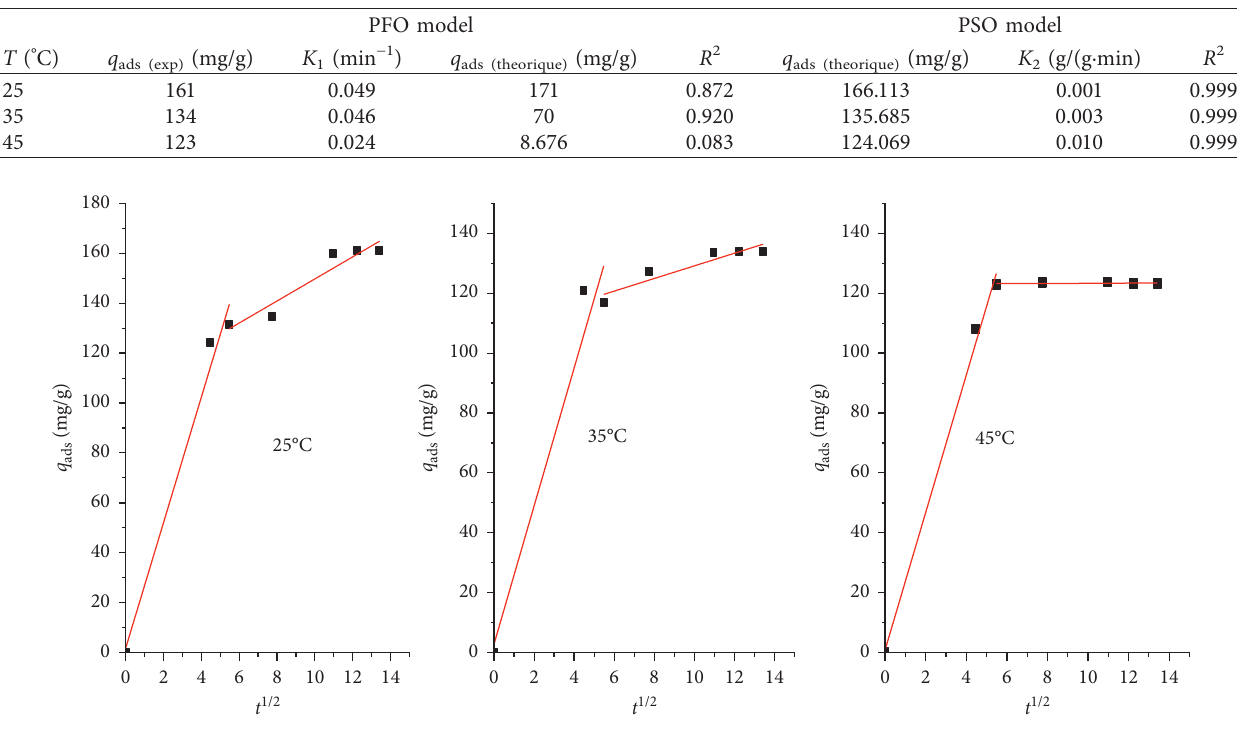
Figure 9: IPD plots for different Table 4: Parameters of IPD.